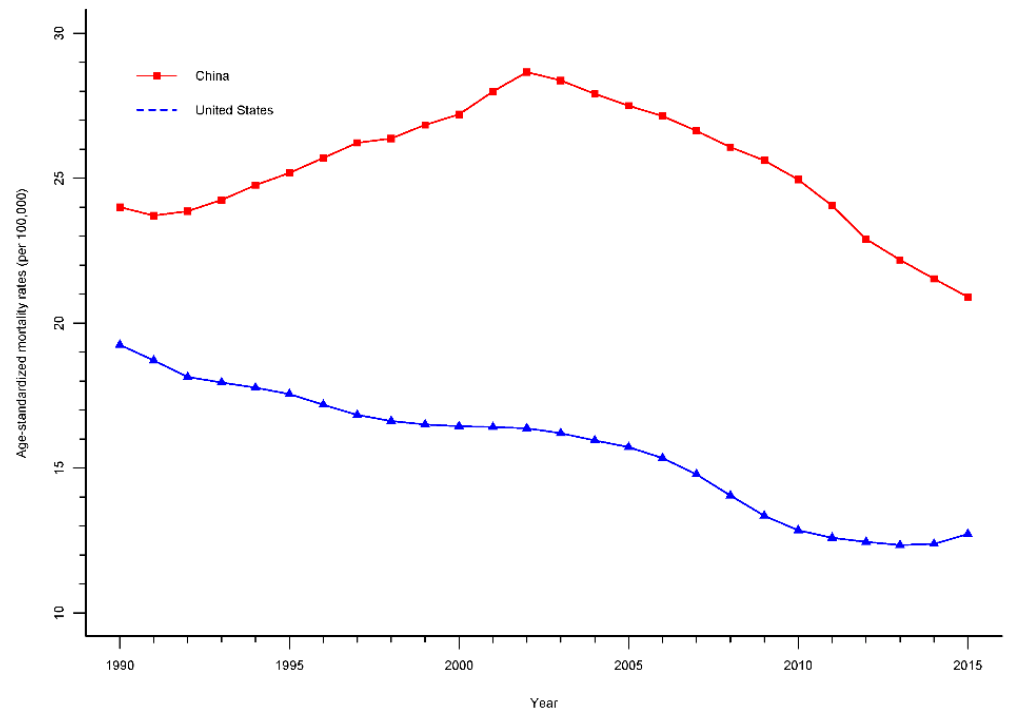
Figure 1. The trends of age-standardized mortality rates for road injuries in China and the United States, 1990–2015.